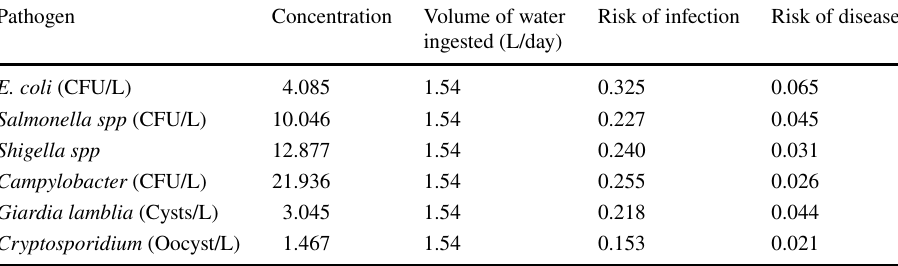
Table 10 Risk of infection and risk of diarrhea